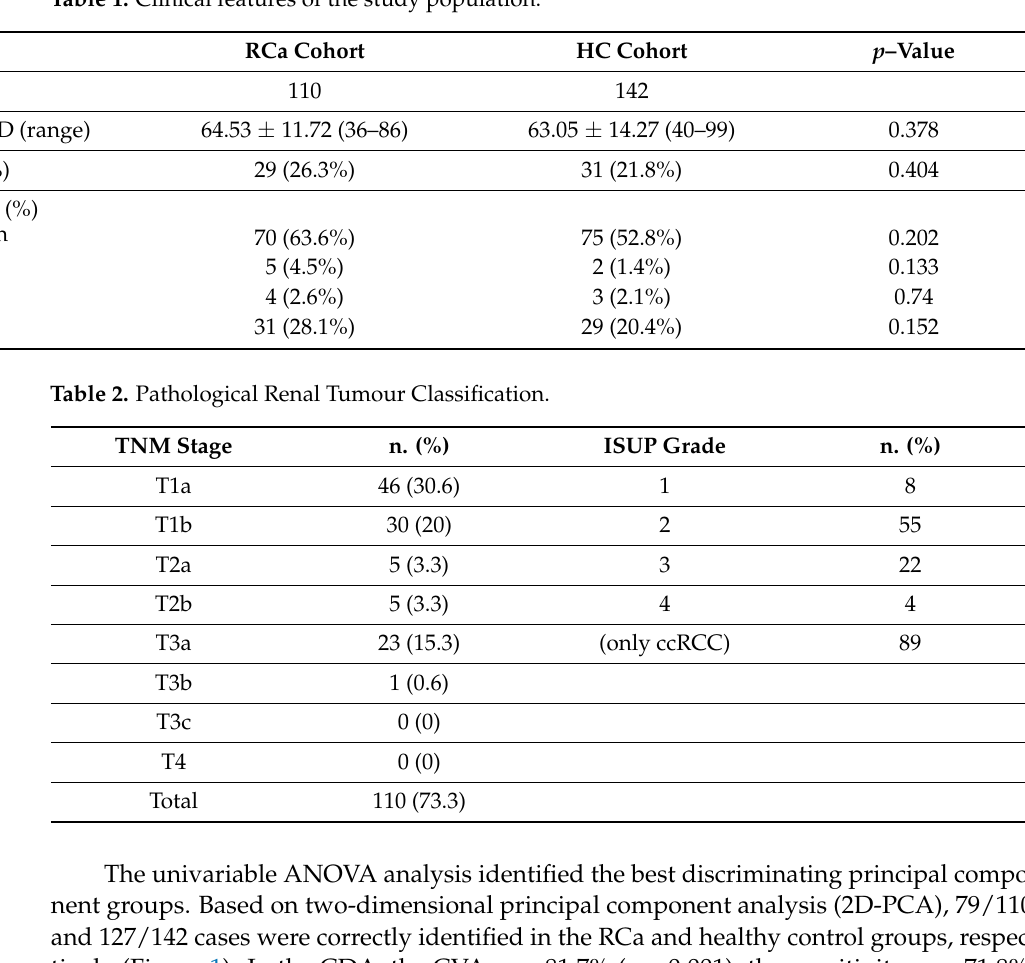
Table 1. Clinical features of the study population.